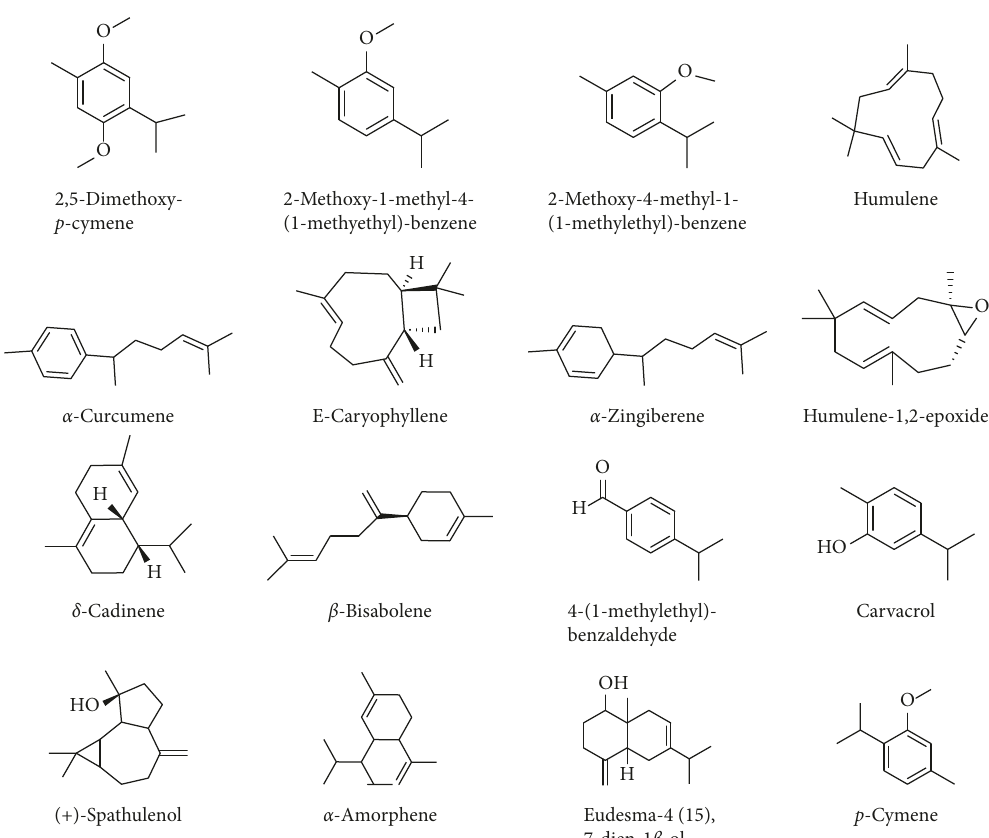
Figure 2: Chemical structures of the first 16 major components of CSEO. The chemical compounds with peak area percentage ≥ 0.11%.